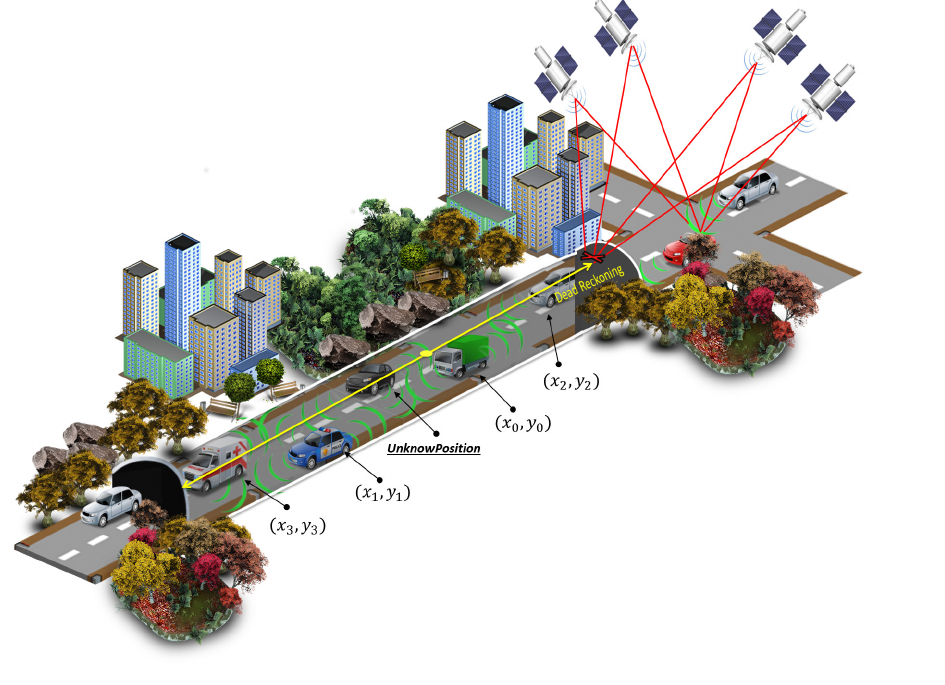
Figure 3. Integrated Cooperative